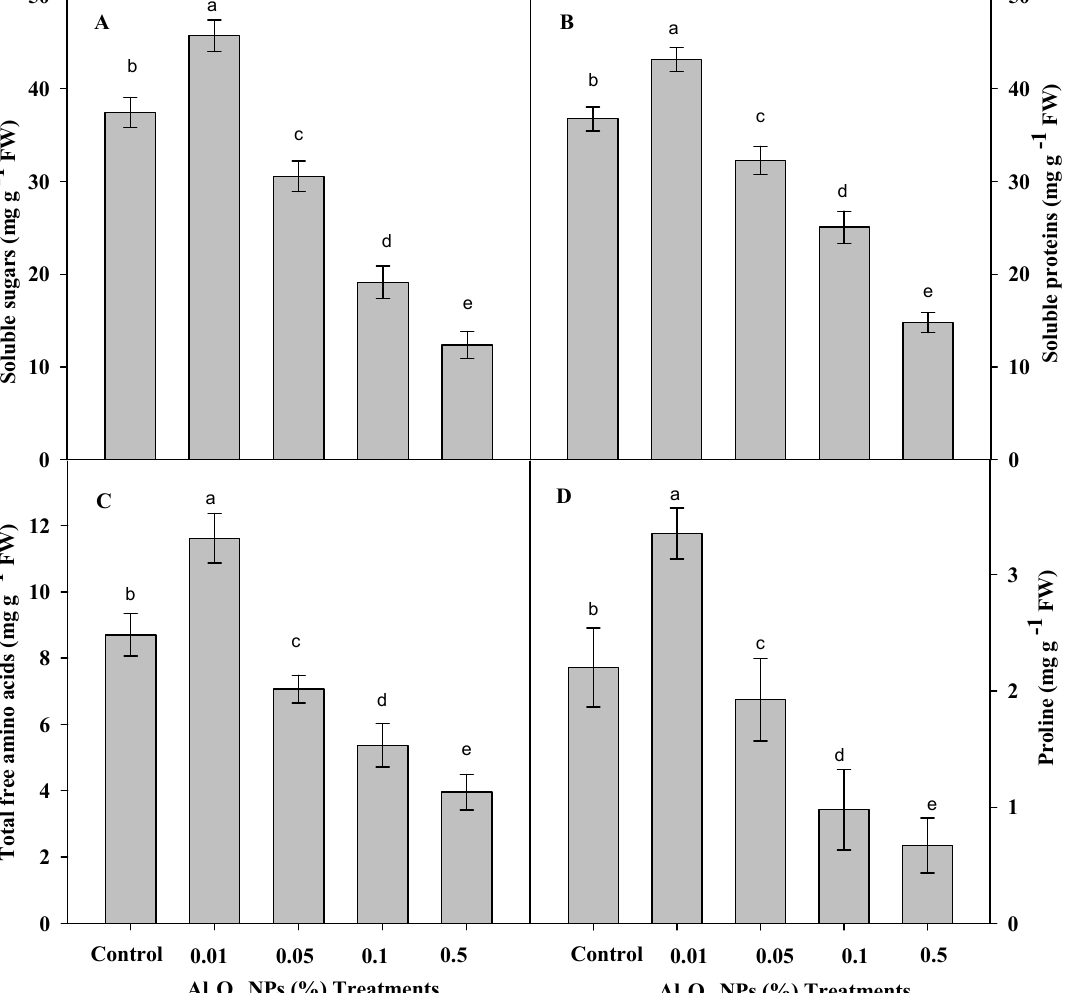
Figure 3. Effects of seed-priming with aluminum nanoparticles (Al 2 O 3 NPs) on (A) chlorophyll a, (B) chlorophyll b, and (C) carotenoids content in roselle plants. Bars represent standard deviation (±SD) of the means ( n = 3). Different letters indicate significant differences among the treatments at p ˂ 0.05, according to Duncan’s multiple range test.